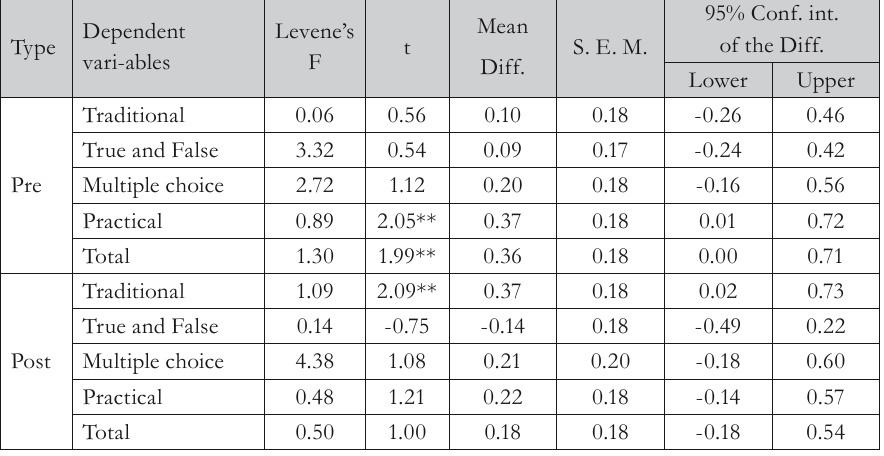
Tab 6 – Comparison of female and male self-estimation with independent t-test, Source: